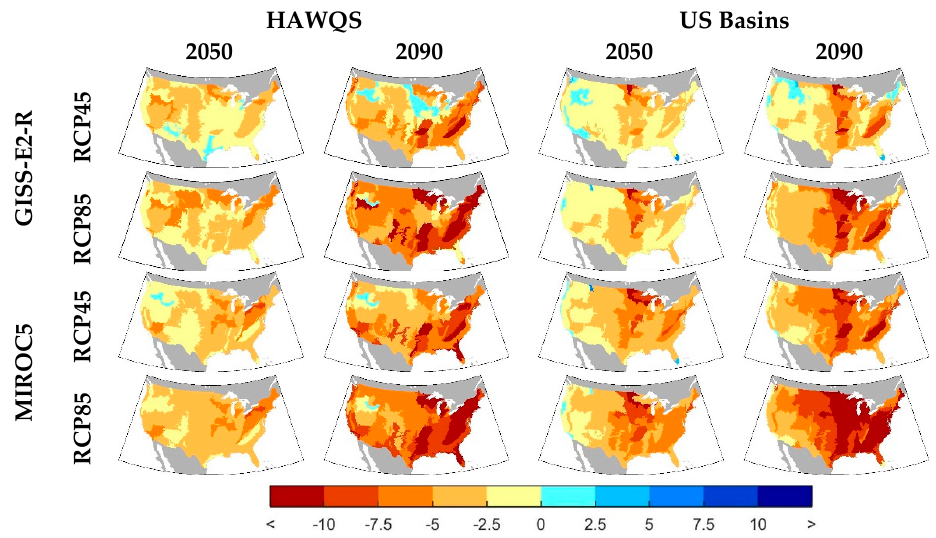
Figure 12. Changes in mean ( left ) HAWQS and ( right ) US Basins Willingness to Pay per person (USD/year) at the Level ‐ III Ecoregion scale for both the GISS ‐ E2 ‐ R and MIROC5 climate models, two emissions scenarios, and two eras.